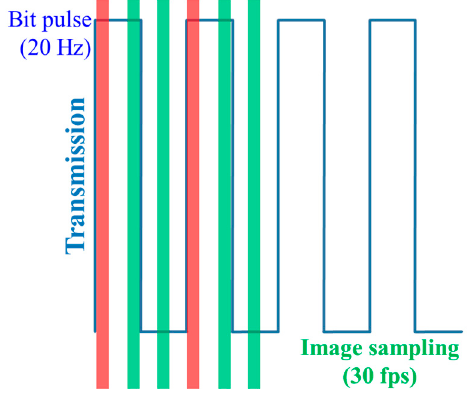
Figure 23. Selecting two good frames among three adjacent captured frames.